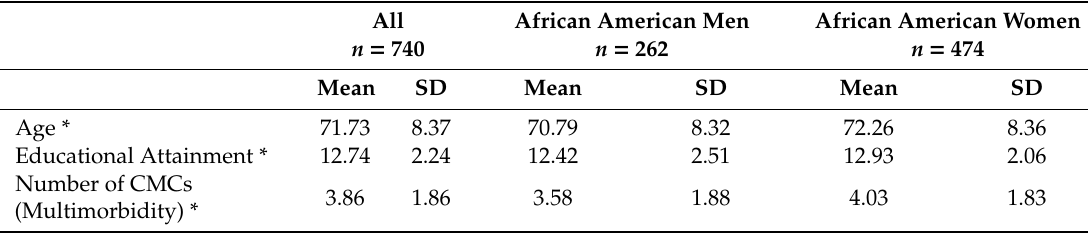
Table 1. Descriptive Statistics of the sample, both pooled and by